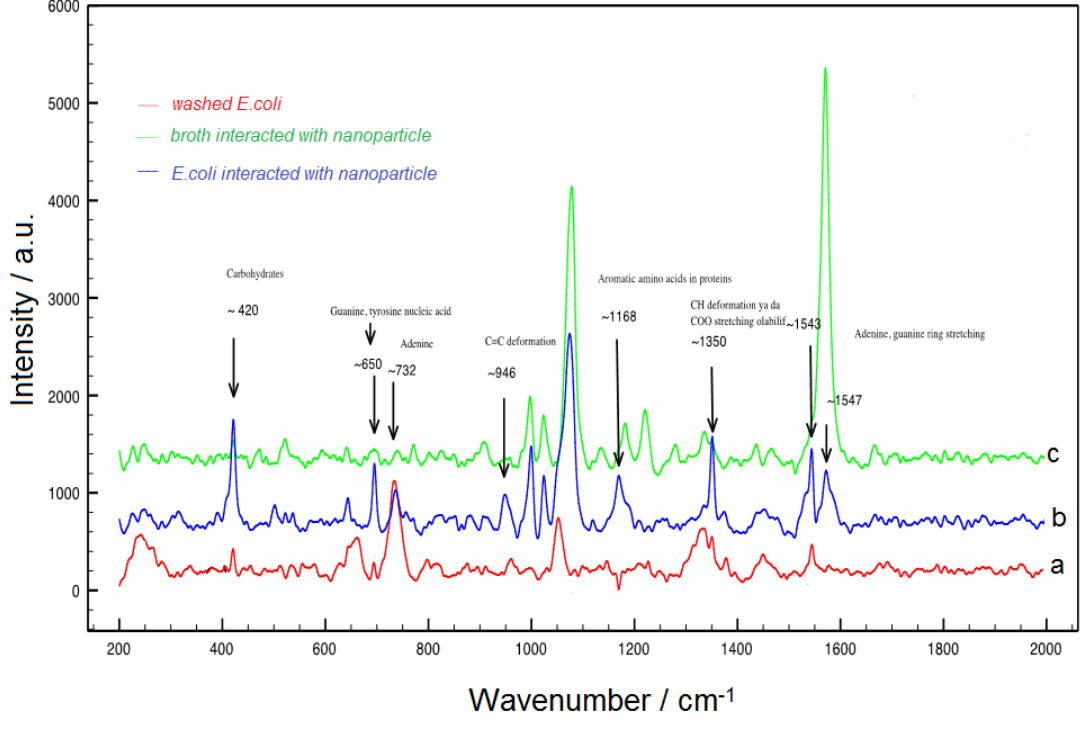
Figure 7. Surface-enhanced Raman scattering (SERS) spectrum of ( a ) 10 7 cfu mL − 1 E. coli ; ( b ) E. coli interacted with 3-MBA/1-DT-modified magnetic nanoparticles; ( c ) bacterial growth solution interacted with 3-MBA/1-DT-modified magnetic